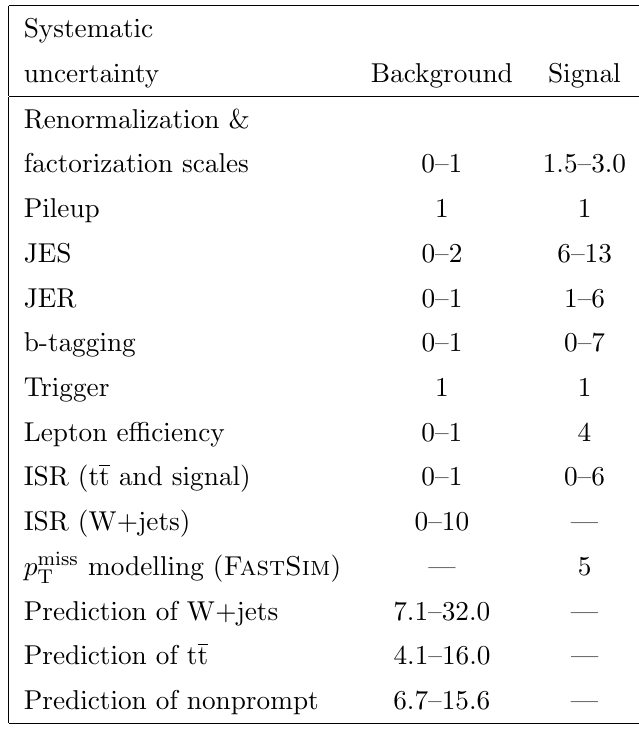
Table 4 . The MVA search: relative systematic uncertainties (in %) on the total background and signal prediction. The \|" means that a certain source of uncertainty is not applicable. In the case of the background, the uncertainties are on the total background. Systematic uncertainties on the data-driven prediction of the W+jets, tt, and nonprompt lepton backgrounds are reported.